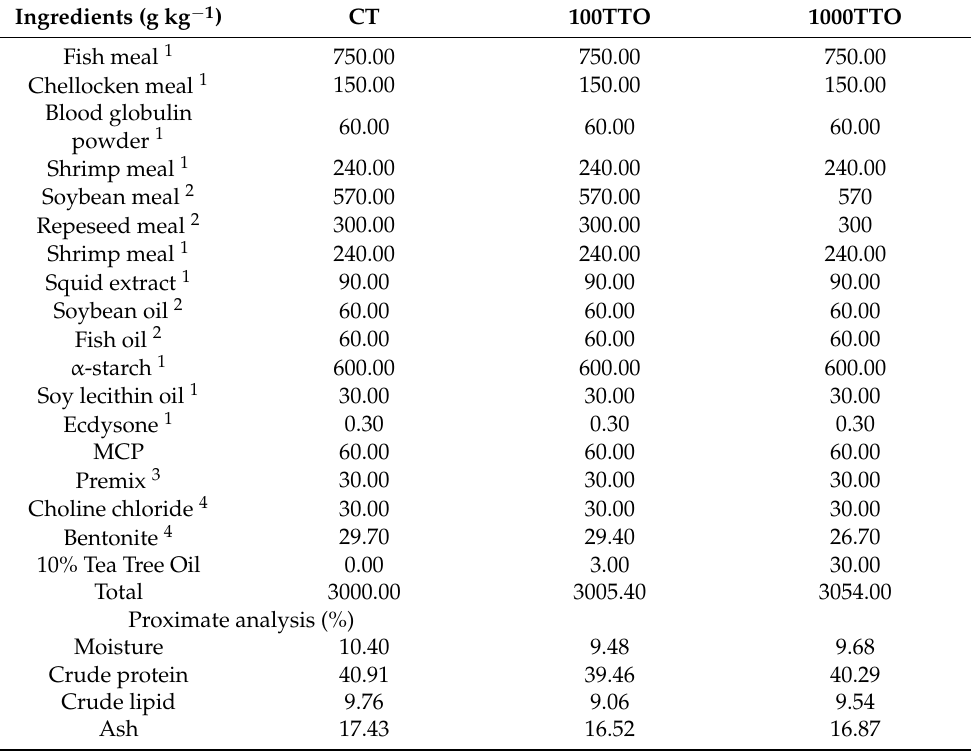
Table 1. The formulation and proximate composition of the experimental diet. Ingredients (g kg − 1 ) CT 100TTO 1000TTO Fish meal 1